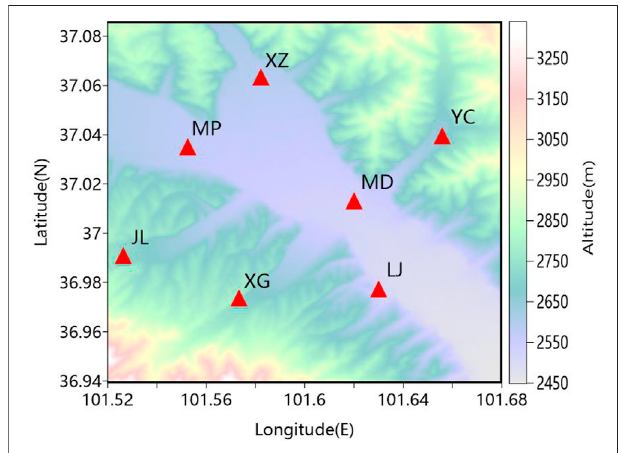
FIGURE 1 | Layout of the detectors (unit (cid:2) meter; longitude and latitude of the central stations (cid:2) E101.6,200,592 and N37.0133,483,